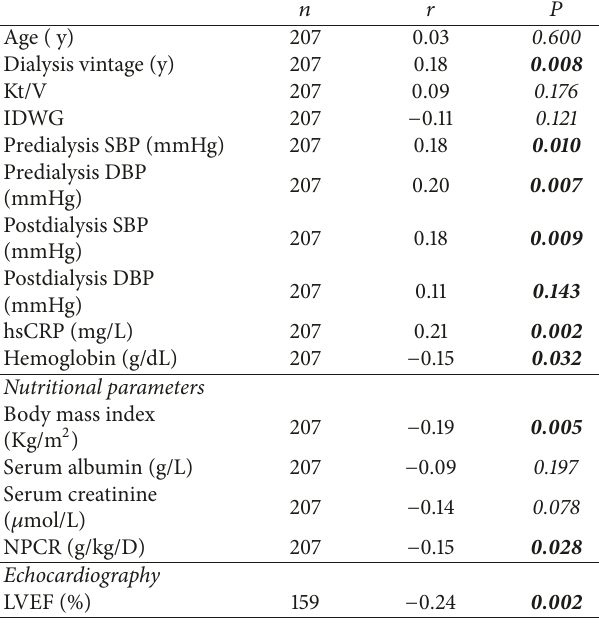
Table 2: Correlations between log NT-proBNP and clinical, biolog- ical, and echocardiographic